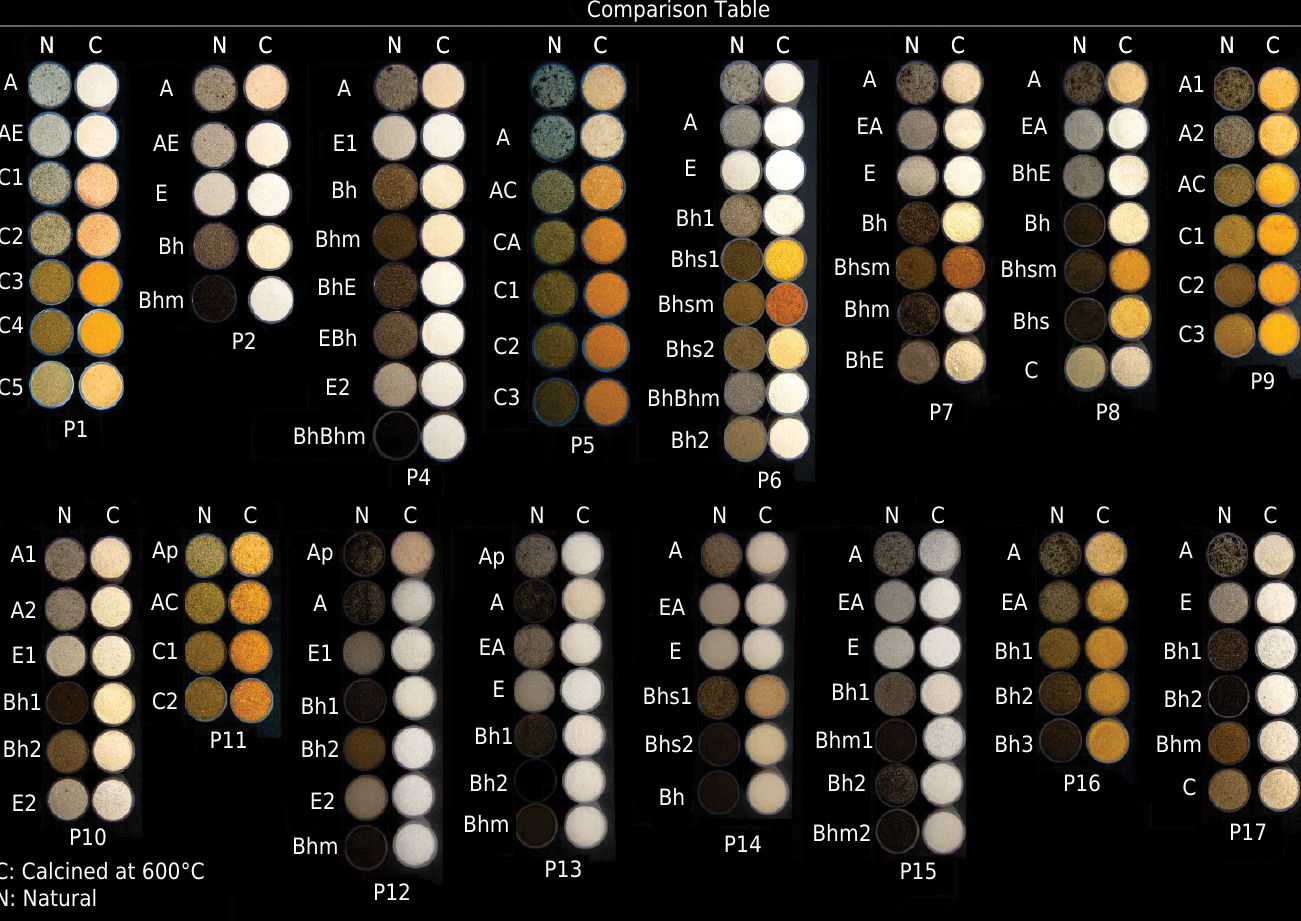
Figure 2. Comparison table of all soil samples before and after calcination at 600 °C. The names of the horizons are in accordance with the reclassification after the application of the calcination